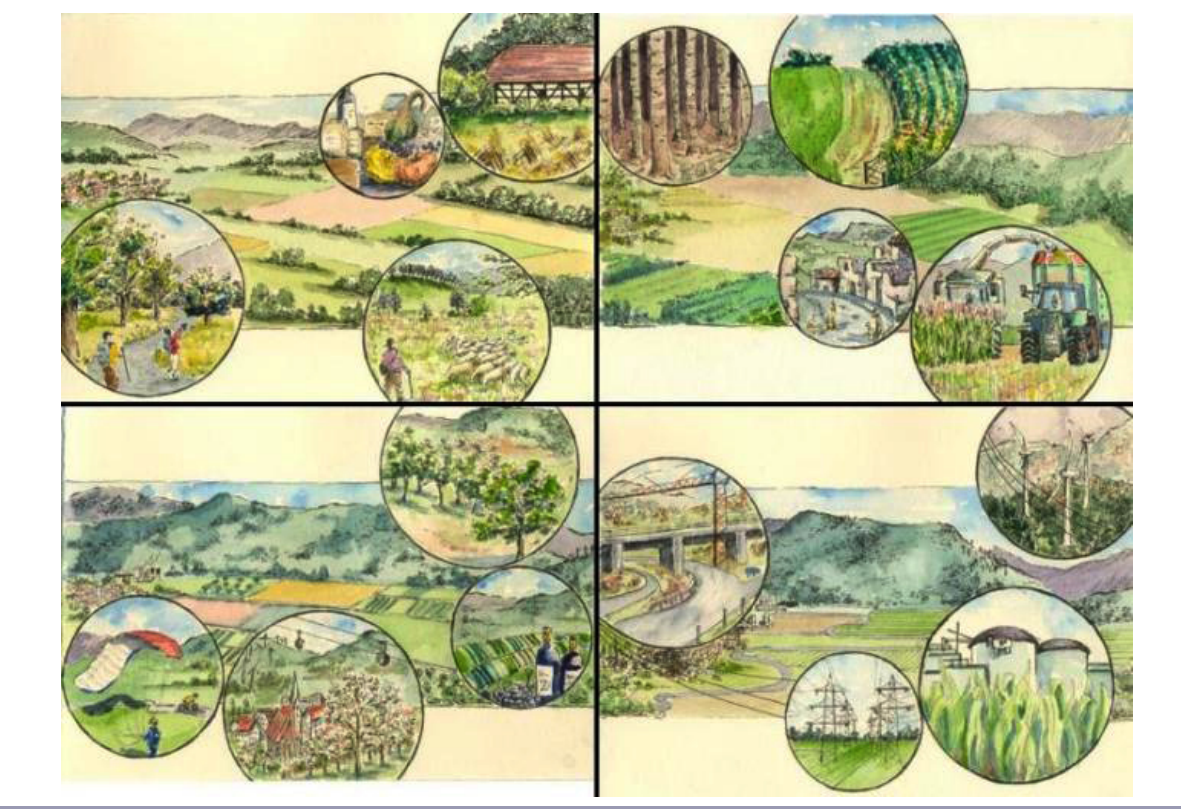
Fig. 9 . Visualization of the “less is more,” “AlbGAU,” “spirit of invention,” and “energy silo” scenarios (moving from top left to bottom right). Design: A. Rodríguez García.